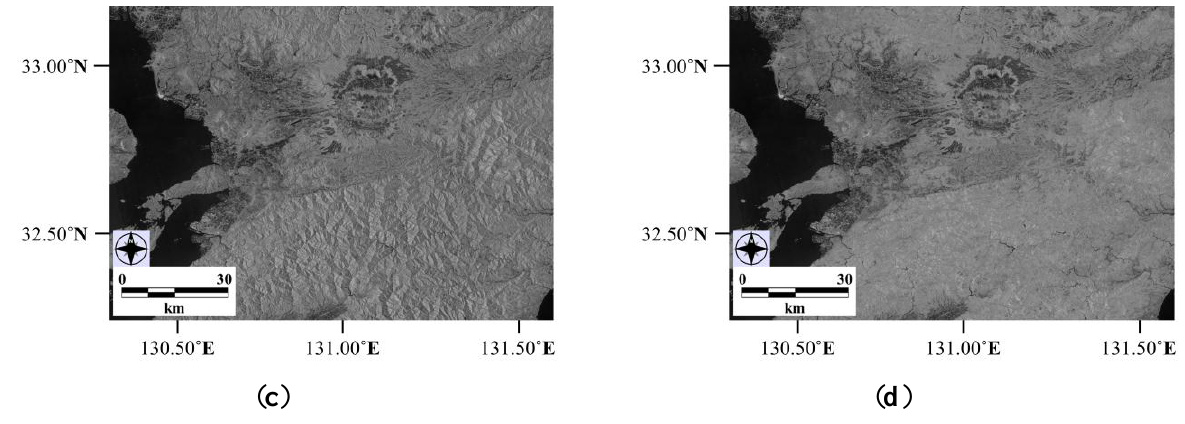
Figure 5. Visual interpretation of the Phased Array L-band Synthetic Aperture Radar (PALSAR) 50 m at the Kyushu Island region, for ( a ) the original image and ( b ) the slope - corrected image of the HV polarization data. The ( c , d ) images show the zoomed areas from the (a,b) images, respectively.